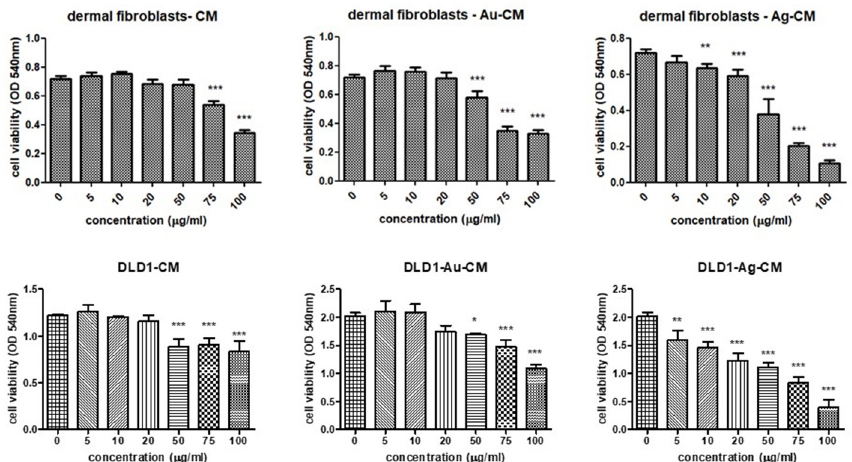
Figure 7. Viability of HDF and DLD-1 cells exposed to Au-CM and Ag-CM at different concentrations (0 – 100 µg/mL) compared to unexposed control cells or cells exposed to CM extract. Data are presented as mean OD 540 nm ± SD, (n = 3) (* p < 0.05, ** p < 0.01, *** p < 0.001 treated cells vs. untreated control cells).